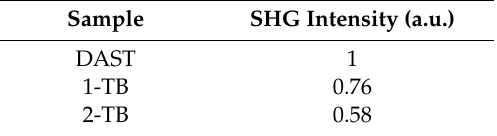
Table 2. Second-order nonlinear intensity at 1064 nm for powders of the DAST, 1-TB, and 2-TB.